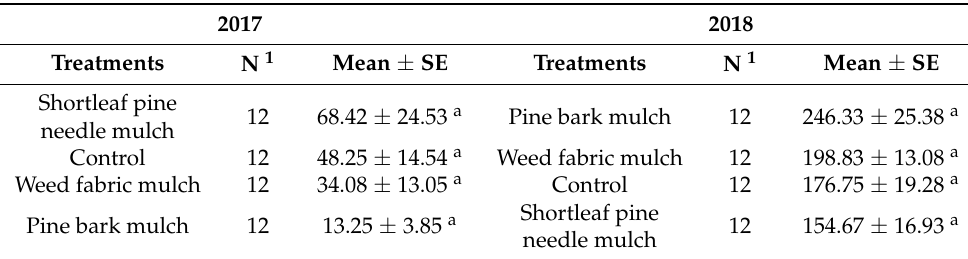
Table 4. Average numbers of adult D. suzukii caught on blueberries with different mulching practices using Scentry ® traps during the sampling periods in 2017 and 2018.